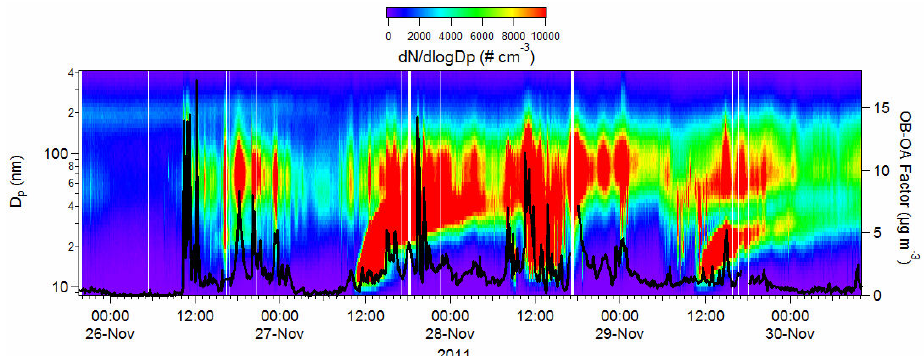
Fig. 13. Size distributions (left axis) plotted with the otBB-OA factor (black solid line, right axis) versus the time from the data set 26 to 30 November. When the otBB-OA contribution increases the particle diameter is around 60-70 nm.